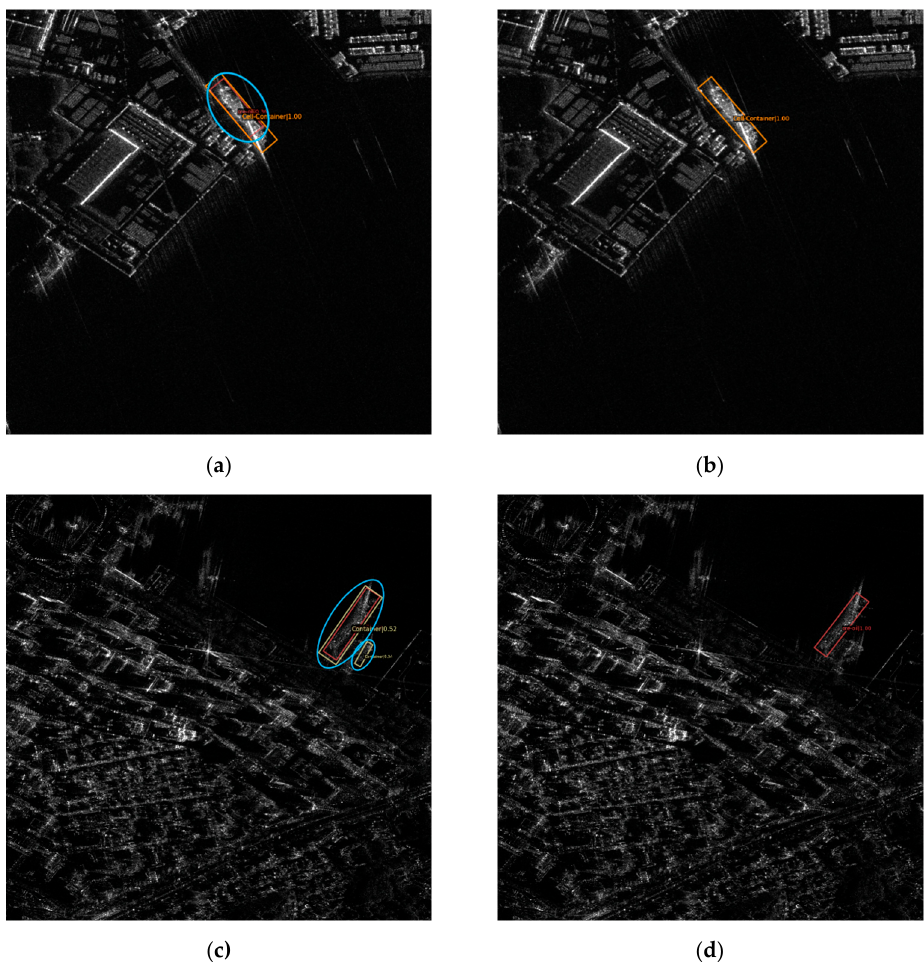
Figure 10. Detection results of the baseline without and with RIC Loss. The blue ellipse represents false alarm. ( a , c ) Detection results of the baseline. ( b , d ) Detection results of the baseline with RIC loss.